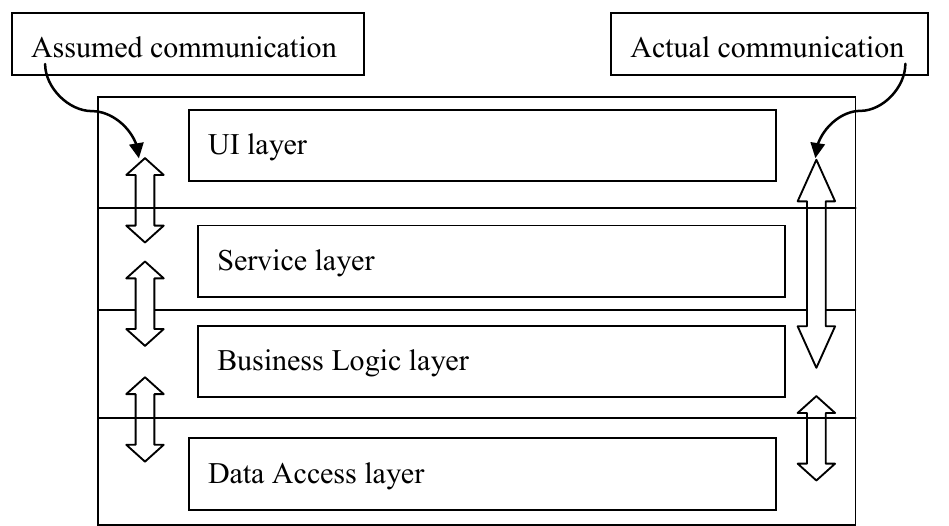
Figure 3. Assumed and actual communication between architectural